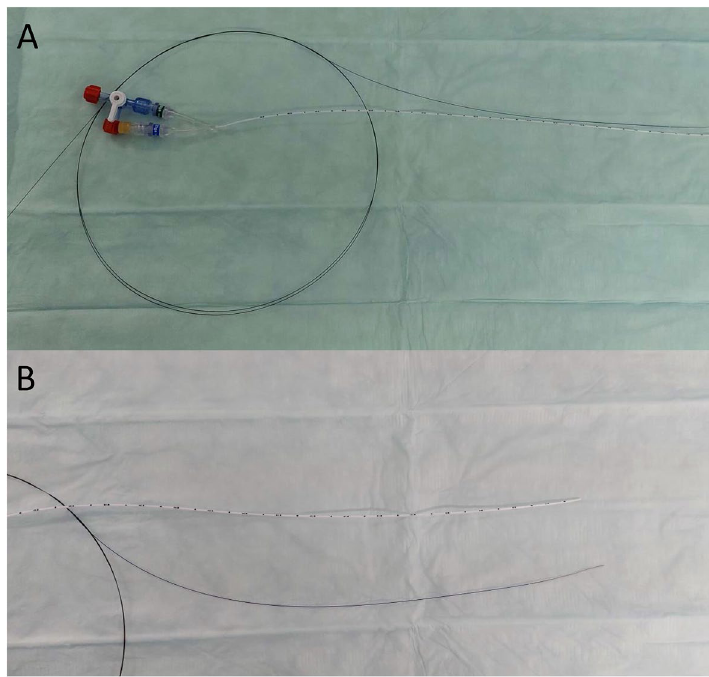
Fig. 1 Coronary guidewire and umbilical catheter. A Guidewire loop and umbilical catheter with luer-lock connector. B Tip soft end of guidewire and umbilical